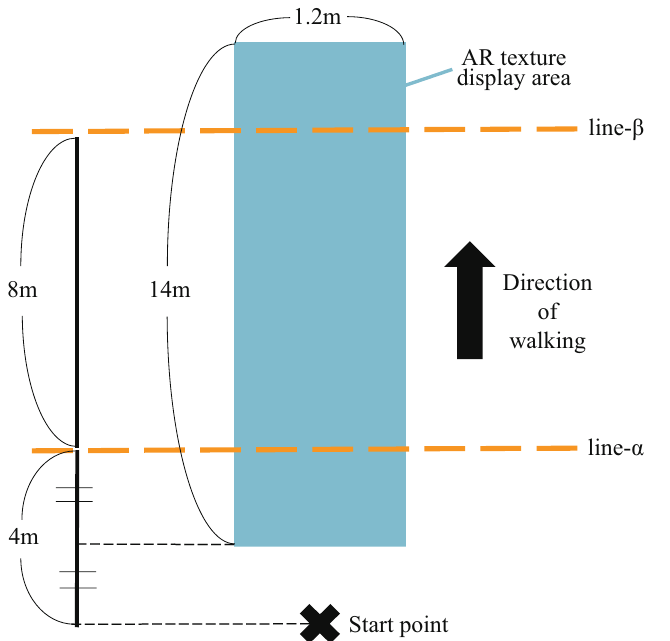
Figure 17. The experimental environment when displaying the AR moving walkway